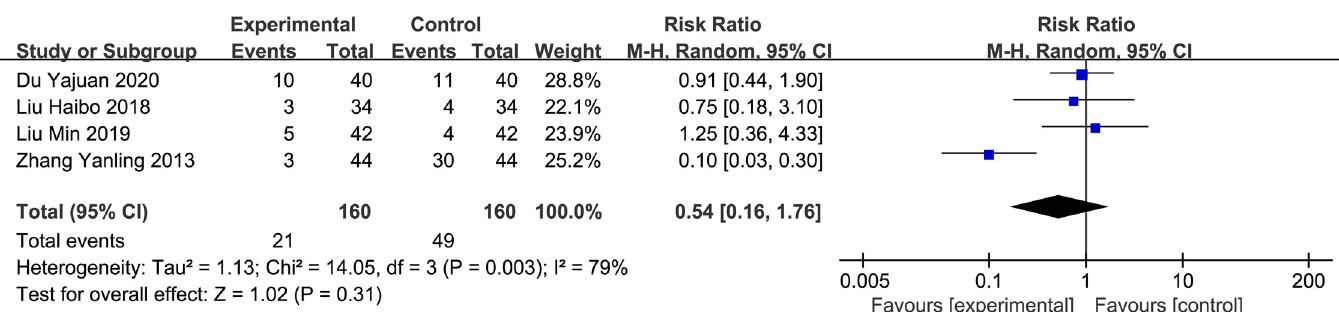
Fig 8. Forest plot of the incidence of lethargy between experimental and control group.